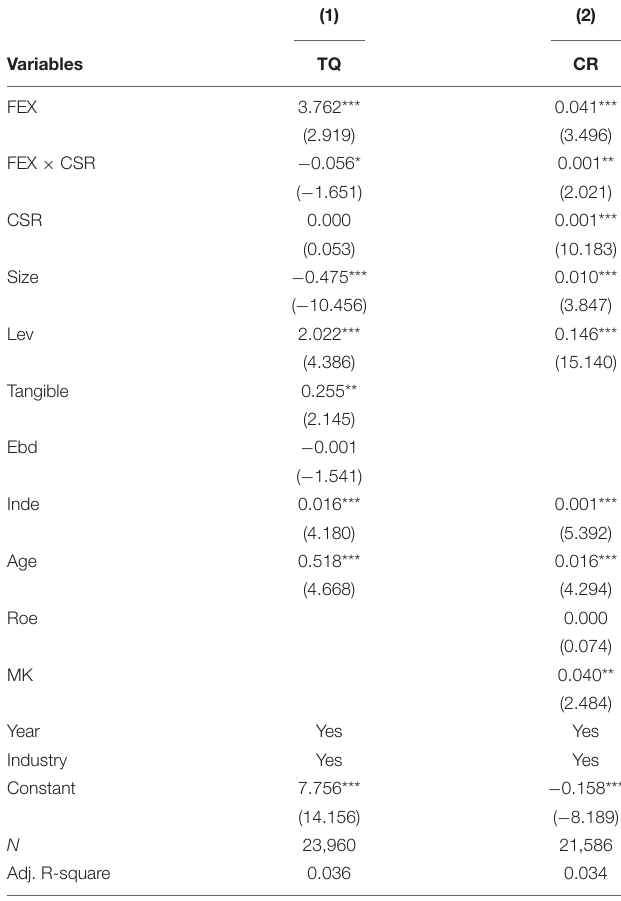
TABLE 5 | The incremental effect of CSR on profitability and corporate